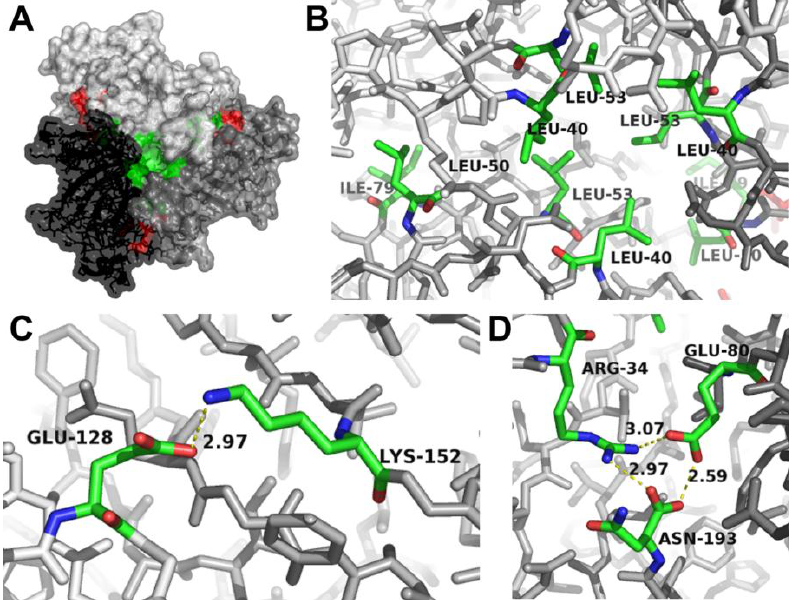
Figure 2. Identification of amino acids at the interaction sites between AOC2 monomers within the trimer. ( A ) Surface representation of the AOC2 trimer (PDB Code 2Q4I). The view is along the trimer axis. The three monomers are given in different gray scales. The hydrophobic core (detailed in ( B )) and the salt bridges (detailed in ( C )) are shown in green and red, respectively. Salt bridges on the back are detailed in ( D ); see Figure S1. (B) Location of Leu40, Leu50, Leu53 and Ile79 of all three monomers building the hydrophobic core of the trimer. (C) Salt bridge (yellow dashed line) between Lys152 of one monomer and Glu128 of the neighboring monomer. The distance between atoms building the salt bridge is given in Å . (D) Hydrogen bonds between Arg34 and Asn193 of one monomer and salt bridges (yellow dashed lines) to Glu80 of the neighboring monomer. The distances between atoms building a salt bridge are given in Å . Interacting faces are shown in stick representation (oxygen, red; nitrogen, blue; carbon, green; atoms not involved in the interaction, gray).